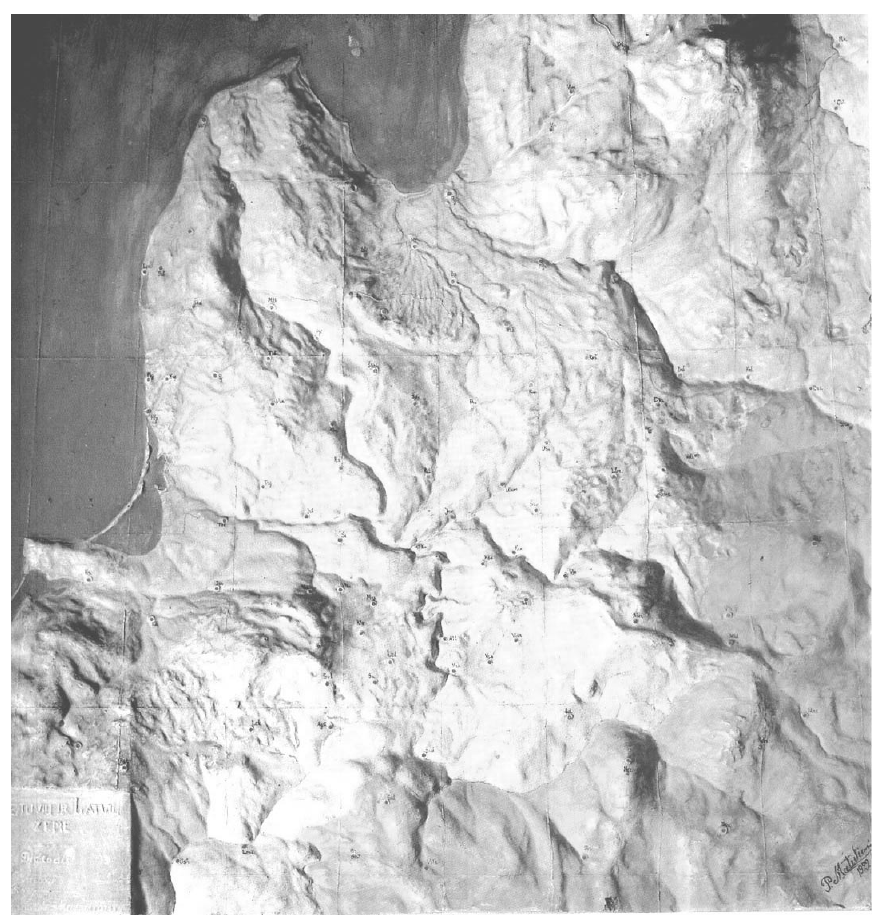
1 pav . Lietuvos ir Latvijos reljefo modelis. Horizontalusis mastelis – 1:1 260 000, vertikalusis – 1:10 000. P. Matulionis. Gipsas Fig 1. Relief model of Lithuania and Latvia. Scale of area – 1:1 260 000, scale of elevation – 1:10 000. Made by P. Matulionis.